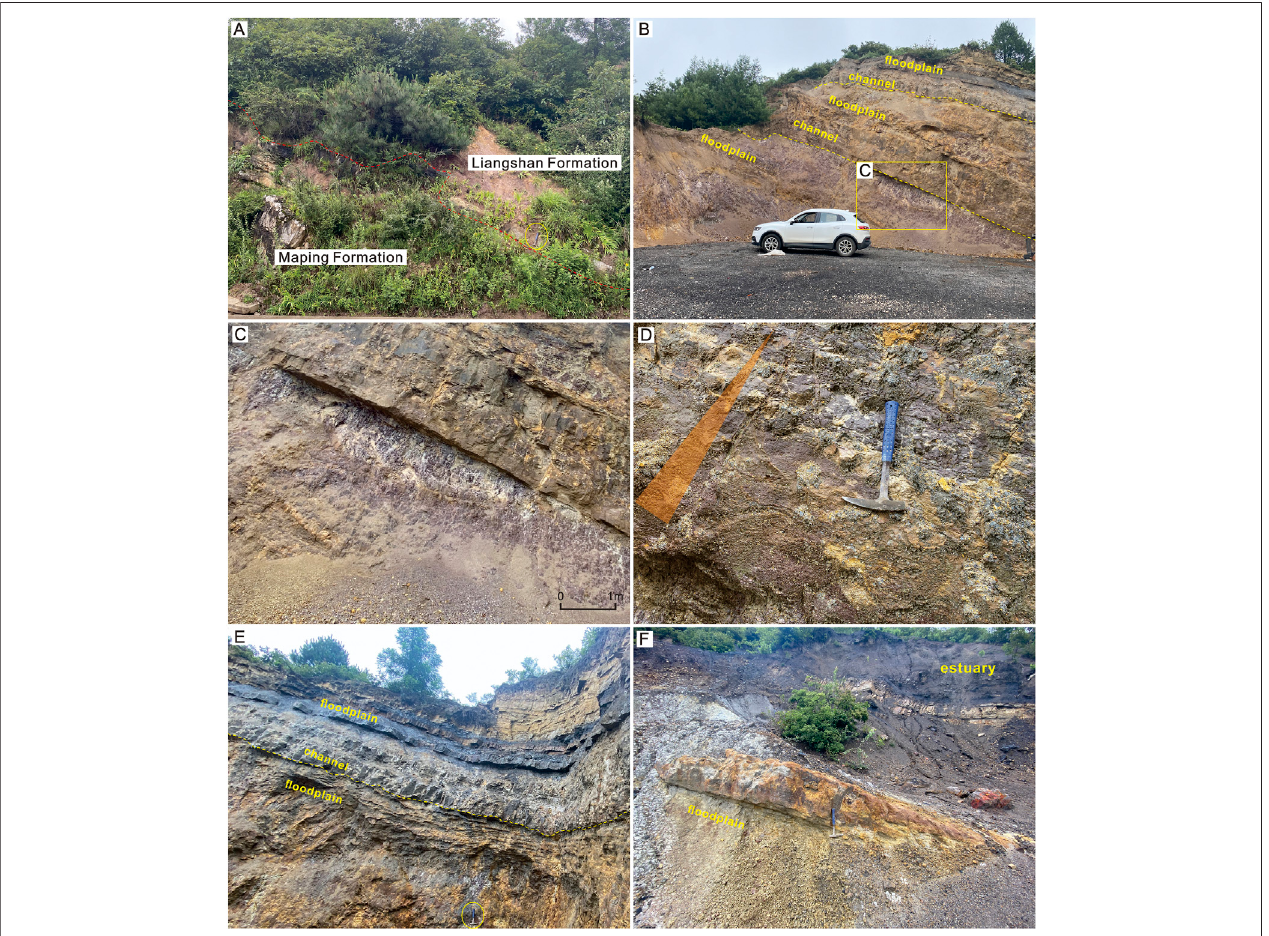
FIGURE3| OutcropphotographsoftheLiangshanFormationintheXiuhesectionandthefaciesinterpretations. (A) Unconformablecontact(reddottedline)ofthe Liangshan Formation between the underlying Maping Formation (Hammer of ~30 cm, circled, for scale). (B) CAP facies associations at the lower Liangshan Formation, showing reddish mudrocks of the coastal fl oodplain, erosionally based sandstone bodies of the coastal plain channel, mottled mudrocks, and dark gray mudrocks. A remarkable color change from purplish red to dark gray was noted. (C) Close-up view of the blocky to prismatic ped structures, plant root traces, and calcareous nodules of reddish mudrocks. (D) Close-up view of the reddish coarse-grained sandstone bed of the coastal plain channel, showing fi ning upward trend. (E) Mottled mudrocksofcoastal fl oodplaininaridclimatecoveredbysandstonesofthecoastalplainchannelandinterbeddedblackmudrocksandsandstonesofcoastal fl oodplain in a more humid climate (Hammer of ~30 cm, circled, for scale). (F) EST facies associations above the coastal plain mudrocks, and sandstones. The mudrocks, sandstones,andcarbonaceousshalesofestuarine fl at,tidalrhythmite,andestuarinemireareinterbedded,andsomeintervalspreservedestuarinechannelsandstones.